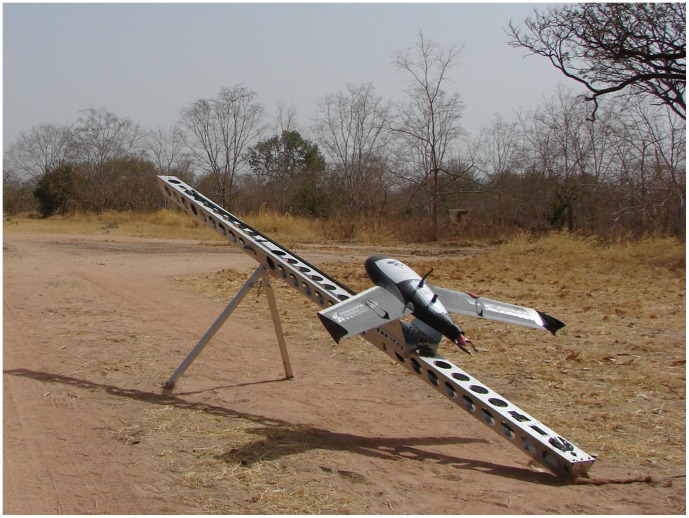
×100 on its launcher.